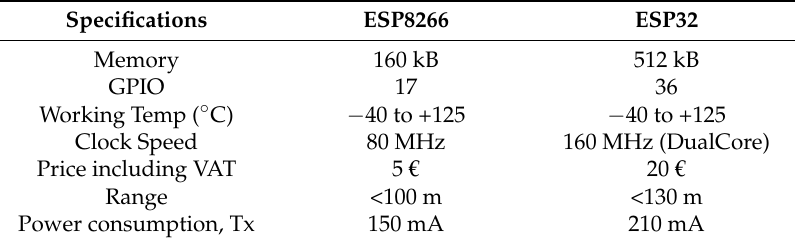
Table 1. Specification of the ESP8266 and ESP32